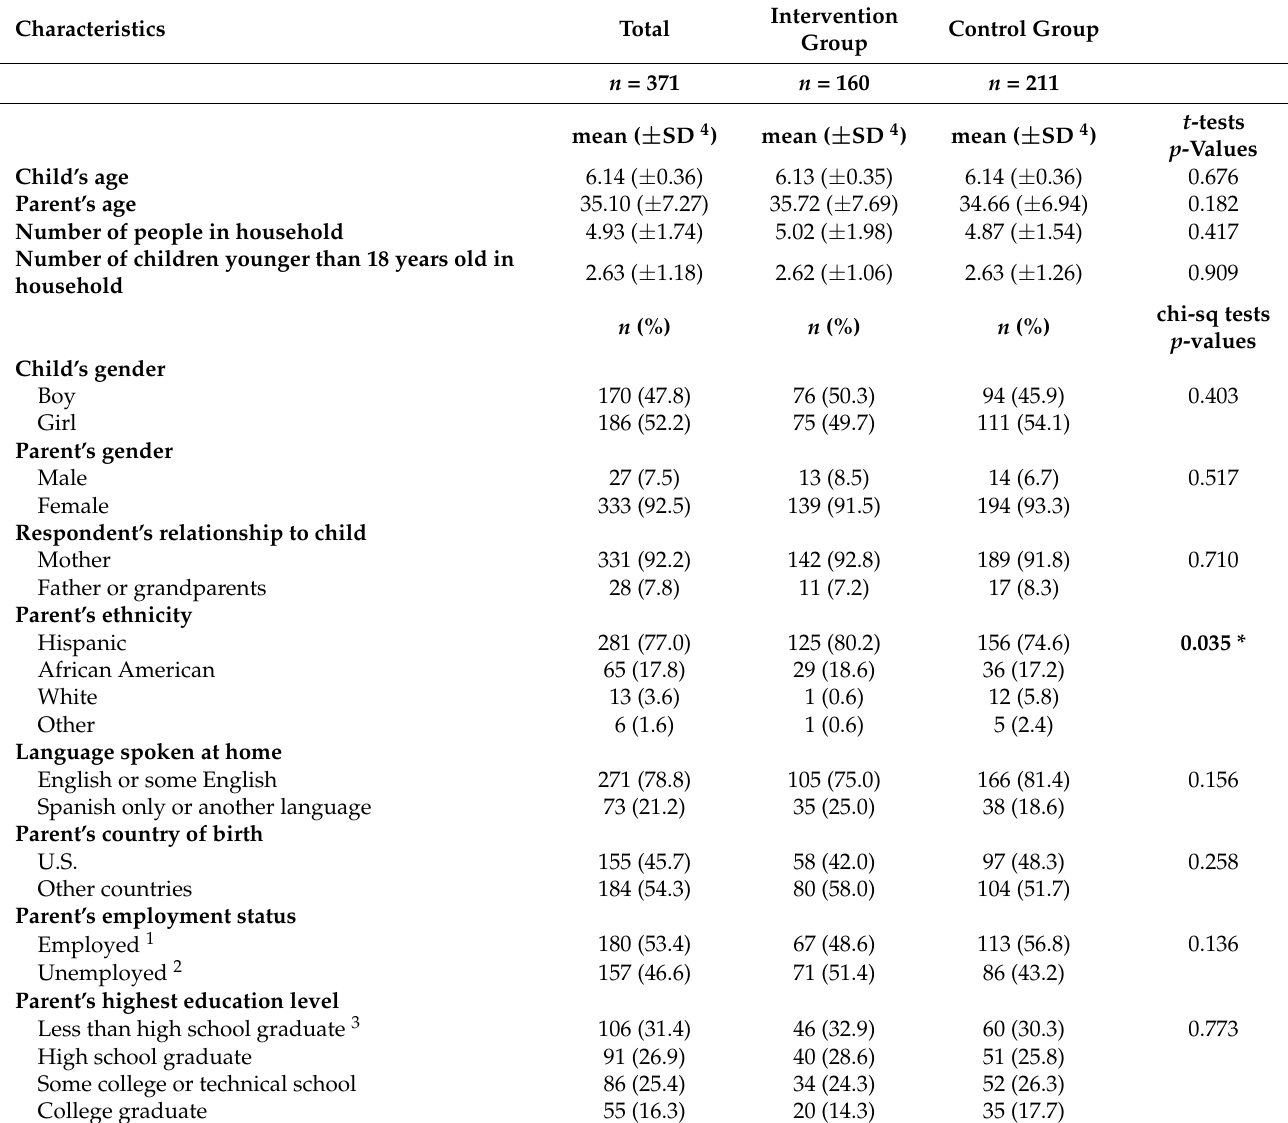
Table 1. Baseline characteristics of